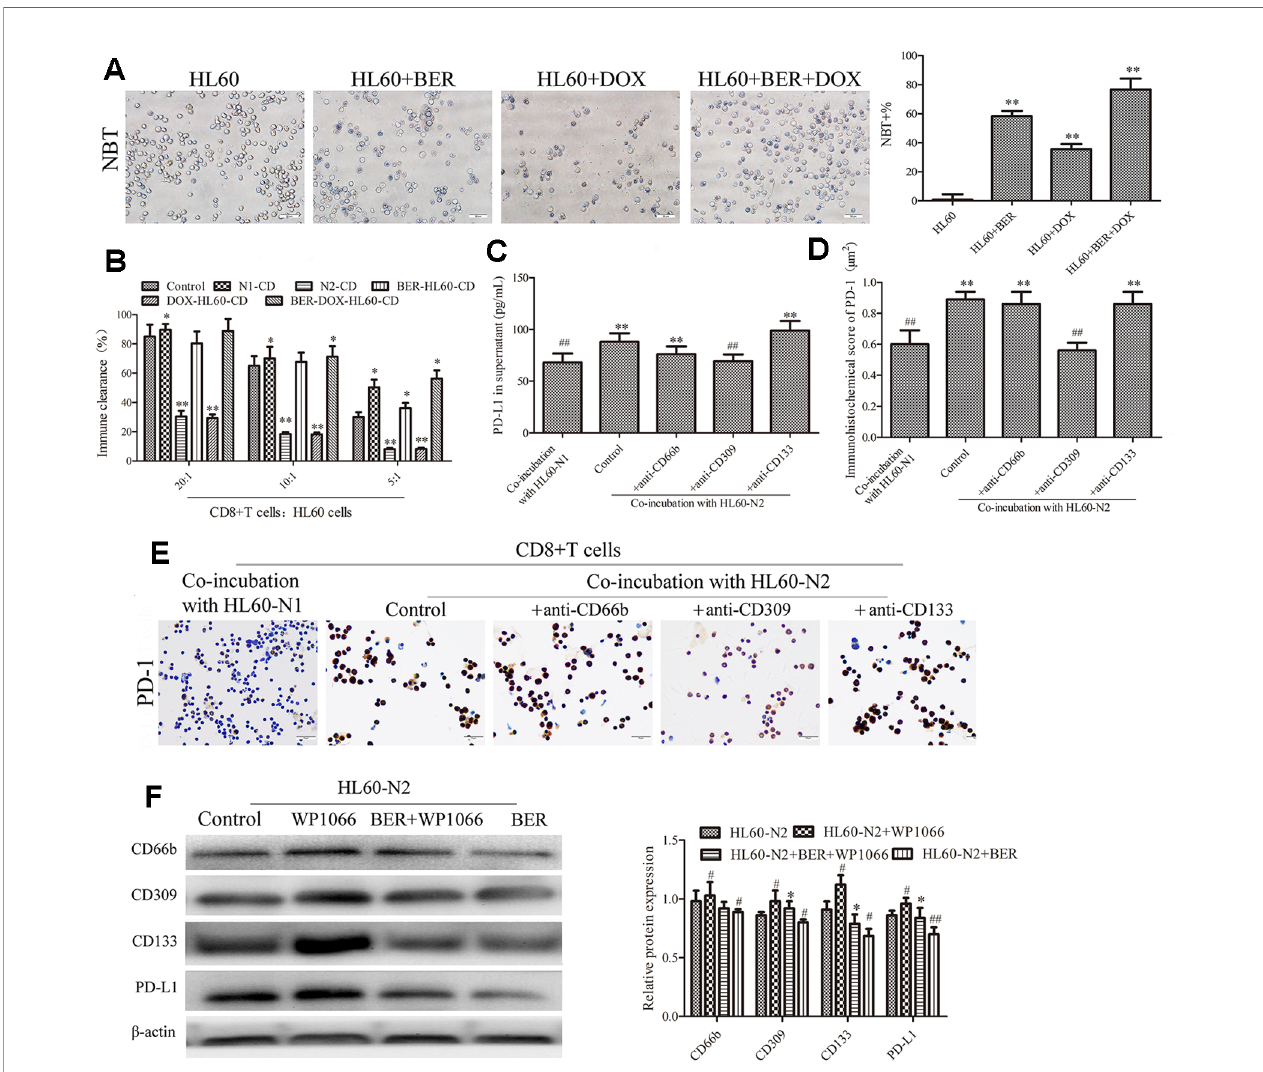
FIGURE 4 | The immunosuppression of N2-like neutrophils is associated with jak2/stat3 signal inhibition and the effect of the drug on HL-60-derived cells. (A) The effect of DOX and berberine on HL-60 cell differentiation (n = 5). (B) N1-like and N2-like neutrophils had different effects on CD8+ T cell immune clearance (n = 5). (C) PD-L1 production in HL-60 cell supernatant (n = 5). (D , E) PD-1 expression in CD8+ T cells examined by immunohistochemistry (n = 5, 40×). (F) and N2-like neutrophil protein expression examined by Western blotting (n = 5). The data present mean ± SD, the experiments were repeated three times, and statistical signi fi cance was determined by a t-test. (A) **P < 0.01 vs . HL60. (b).*P < 0.05, **P < 0.01 vs . control; (C , D) **P < 0.01 vs . HL60-N1; # P < 0.05, ## P < 0.01 vs . HL60-N2. (F) *P < 0.05 vs . HL60-N2+BER; # P < 0.05, ## P < 0.01 vs . HL60-N2. DOX, doxorubicin; BER,